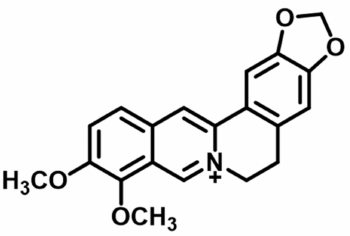
Figure 1. Molecular structure of berberine base form (quaternary